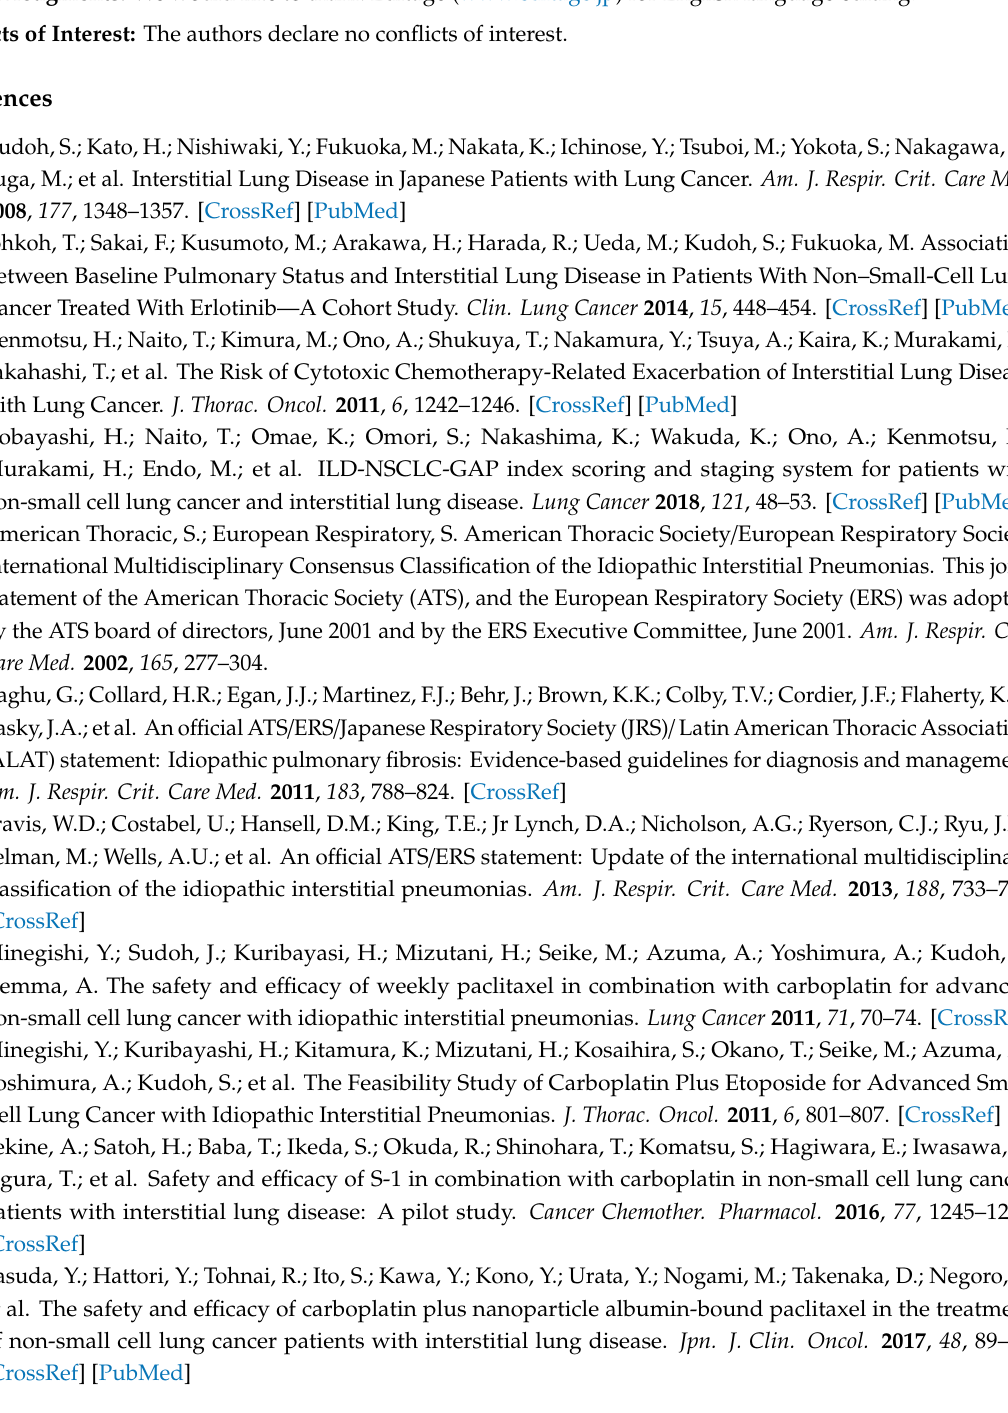
Table S1: List of anti-cancer drug-induced pneumonia patients ( n =